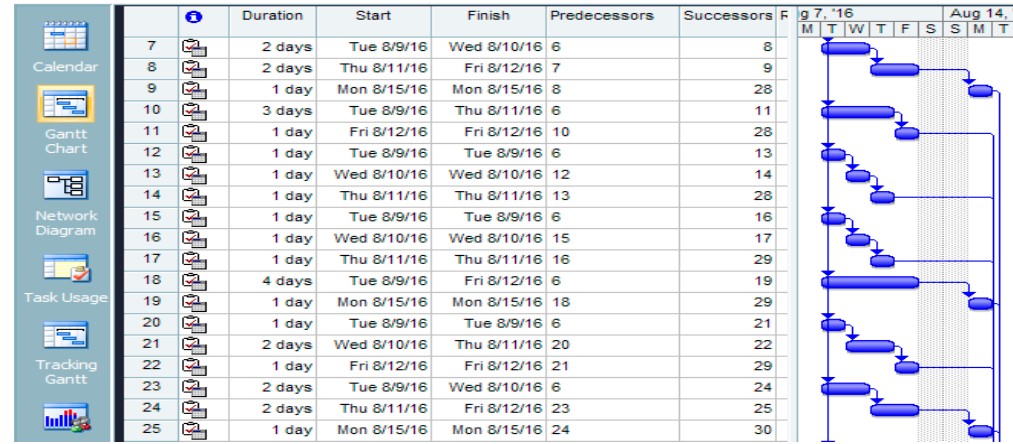
Figure 7. Illustrative part of gantographic display of branched structure of the project to improve the environmental protection system in mining and energy complexes.